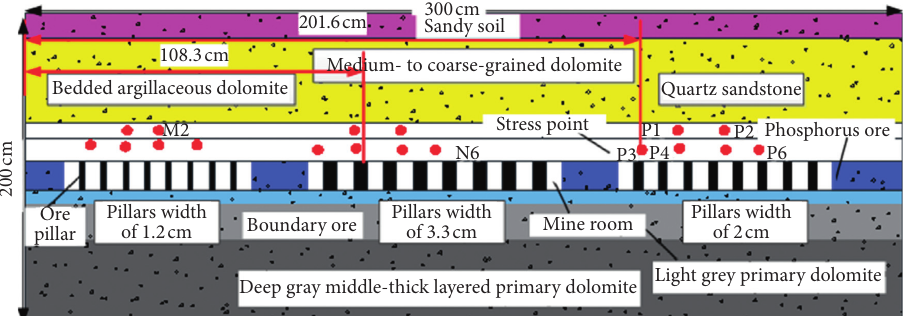
Figure 3: Stress point monitoring in the similar physical model. The mining site at the stress measurement points is a size of 10 × 10m room with the width of 3 × 3 m, 5 × 5m, and 8 × 8 m pillars. These points are labeled M1–M6, N1–N6, and P1–P6, respectively.